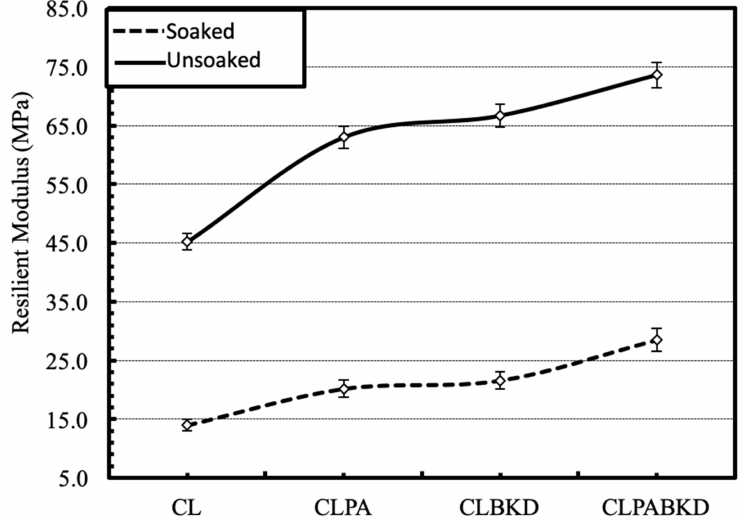
Figure 12. Variation in M R on stabilization of the geomaterial with the optimum contents of pond ash and brick kiln dust under soaked and unsoaked conditions (confining pressure = 13.8 kPa and cyclic deviator stress = 12.4